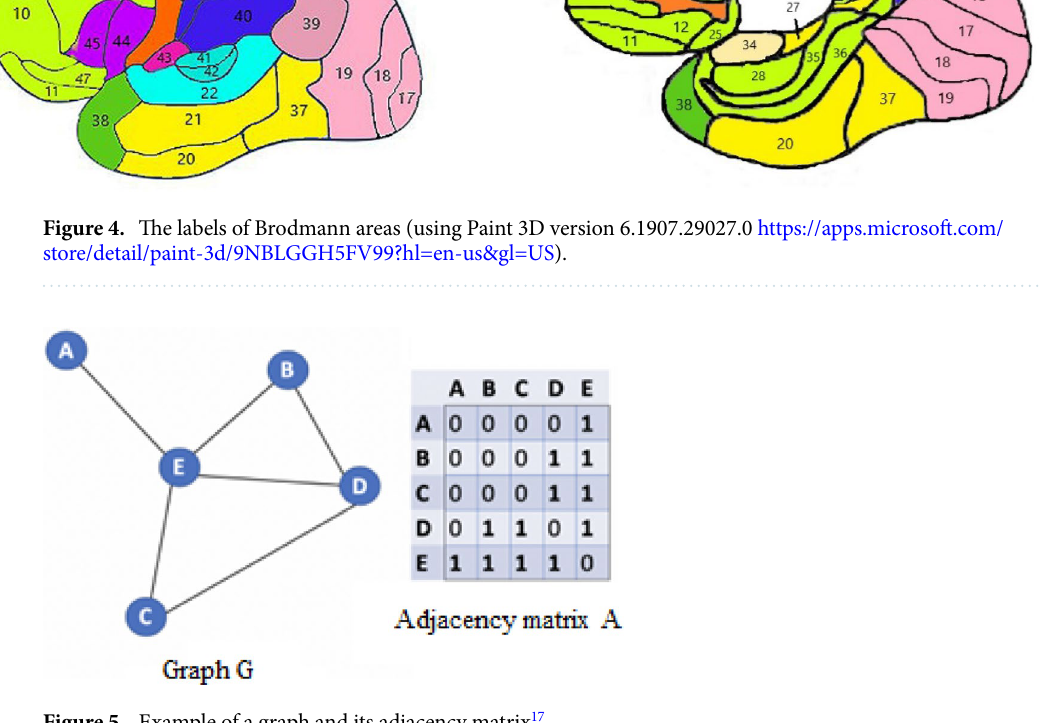
Figure 5. Example of a graph and its adjacency matrix 17